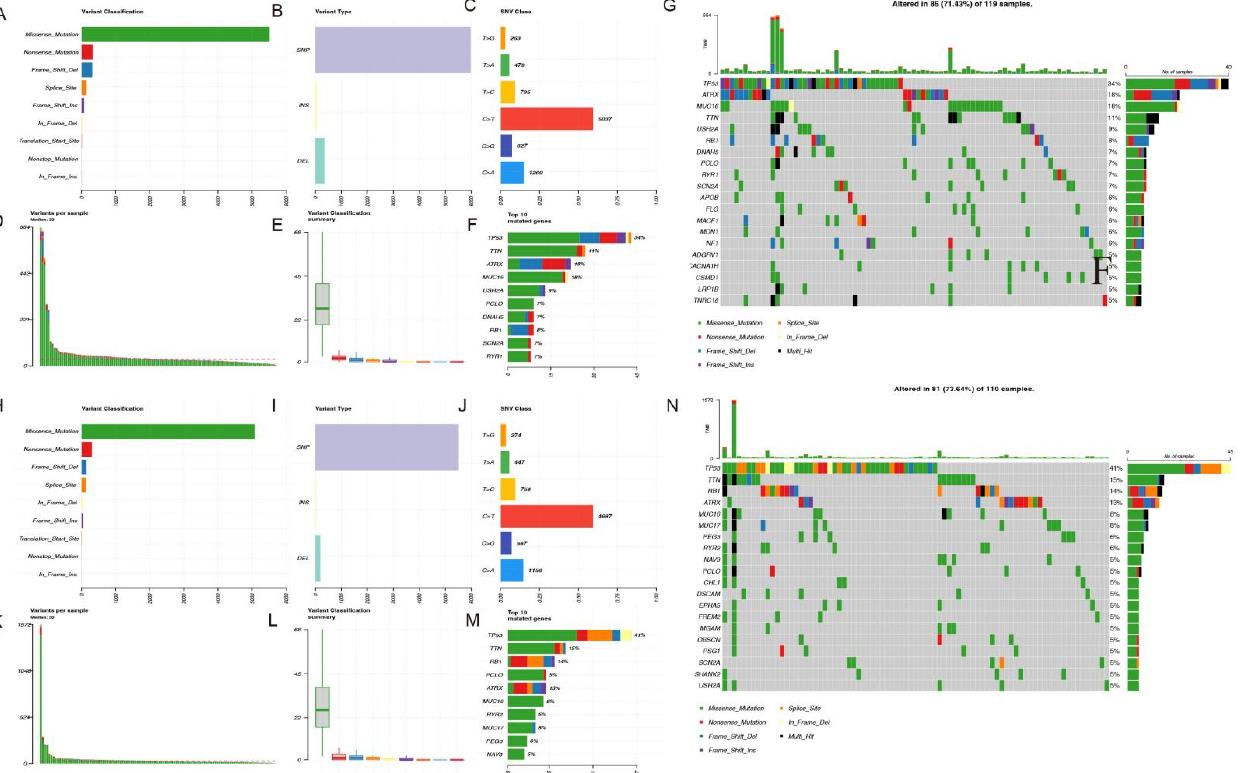
Figure 10. Mutation landscape. ( A – H ) Variant classification. X axis indicated variant numbers. Y axis showed different variant classifications. ( B – I ) Variant type. X axis indicated variant numbers. Y axis represented different variant types. ( C – J ) SNVs type. X axis indicated the ratio. Y axis represented the type of nucleotide substitution. ( D – E , K – L ) The variants per sample and the summary of variant classification. Each sample contains a statistical plot of the number of mutations and a box plot of the classification of the various mutations in the sample ( F – M ) Top10 mutated genes. X axis indicated variant numbers. Y axis represented different genes. The genes were ordered by their mu- tation frequency.) ( G – N ) The upper bar shows the total gene mutation amount and corresponding mutation types. The right bar shows the mutation frequency of the top 20 mutated genes.